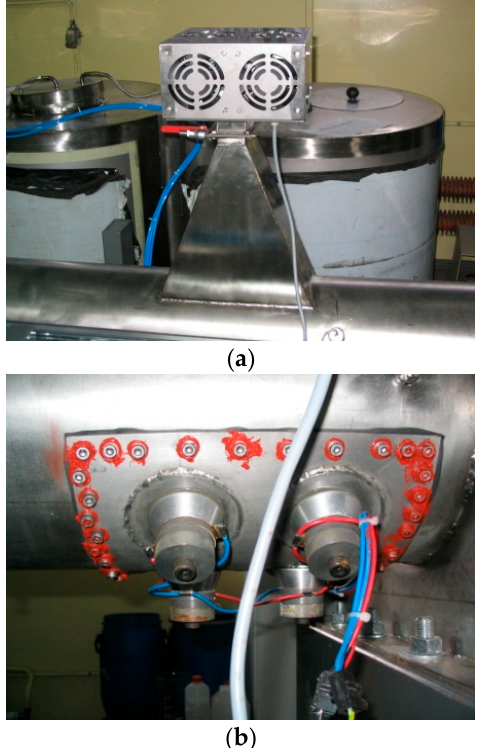
Figure 2. Reactor equipment ( a ) microwave generator, ( b ) ultrasound generator.